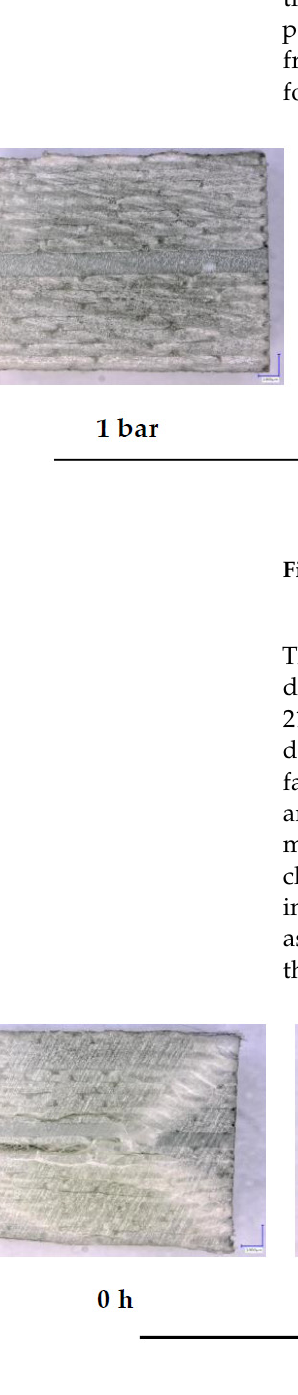
Figure 13. Optical micrographs of adhesively bonded composite loaded through at pressure of 3 bar.